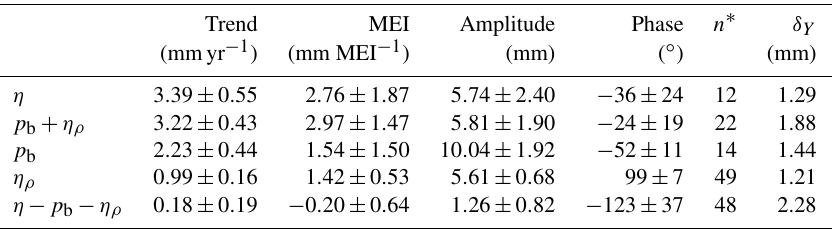
Table 1. Results of OLS applied to altimetric GMSL ( η ), GRACE barystatic sea level ( p b ), Argo steric sea level ( η ρ ), and linear combinations thereof. Values are given as 90% confidence intervals as described in Appendix B. Note that, while the predictors of the OLS fit include an annual sine and cosine, we present results here transformed into the amplitude and phase of a sine term using standard trigonometric transformations. Note also that n ∗ is the effective number of data points (evaluated following Eq. A3 in the Appendix), whereas δ Y is the standard error evaluated for the different data as outlined in Sect. 2.